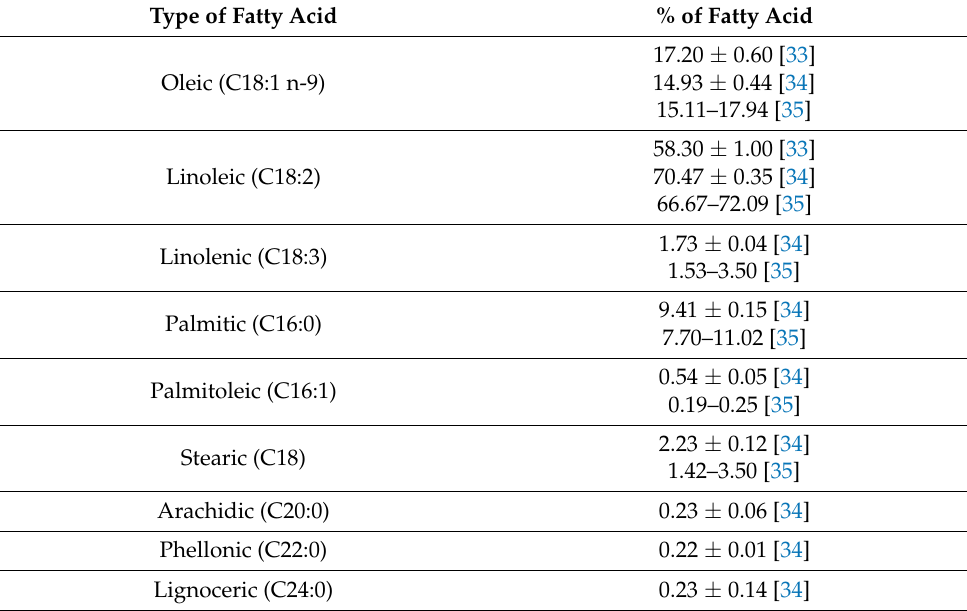
Table 3. Fatty acids composition of S. betaceum seed